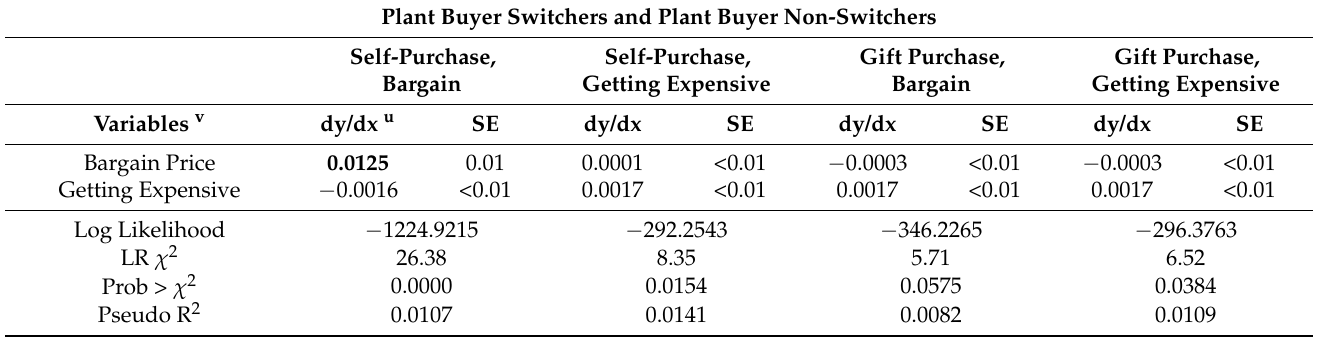
Table 5. Marginal effect estimates from four binary logit models summarizing the effects of the reported bargain and getting expensive prices on the switching behavior between plant buyer switchers and plant buyer non-switchers ( n =